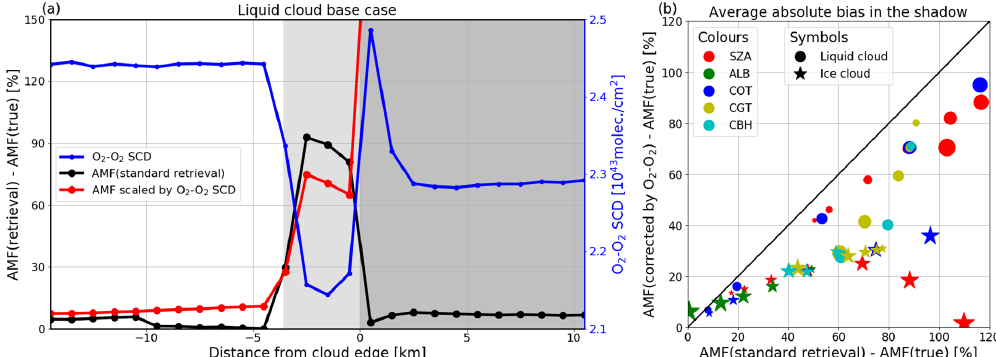
Figure 14. Similar to Fig. 13, but the AMF retrieval is corrected using a ratio of the retrieved O 2 –O 2 SCD and the reference SCD calculated for a clear scene under the same condition.